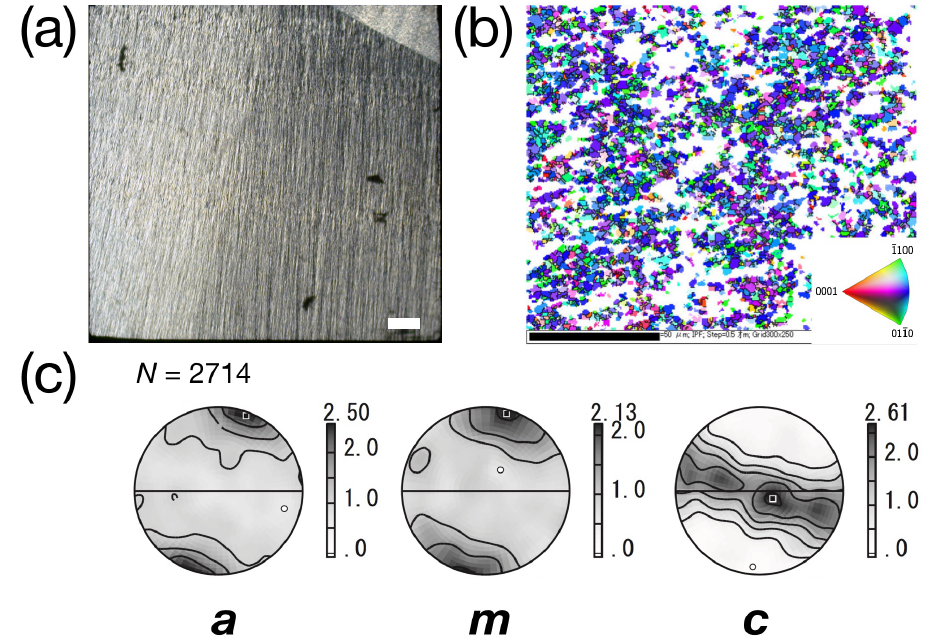
Figure 3. Microstructures of the starting agate sample. ( a ) An optical micrograph of a thin section under crossed polarized lights. The scale bar (white) is 1 mm. Two domains with different fiber orientations are visible in the photograph. ( b ) An EBSD map of an undeformed core sample of agate. The cylinder axis is vertical and the basal plane is horizontal. The quartz fibers were sub-parallel to the cylinder axis. The c -axes of red grains are oriented vertically, whereas those of blue to green grains are oriented horizontally. See the inverse pole figure for coloring of the crystal orientation with respect to the cylinder axis. Crystallographic orientations of blank pixels (white) were not indexed. Scale bar is 50 µ m. The step size is 0.5 µ m. ( c ) Pole figures of crystallographic direction/pole of a (cid:104) 11¯20 (cid:105) , m (10¯10), and c [0001]. The horizontal lines are parallel to the basal planes of the cylindrical samples. N is the total number of measurements.